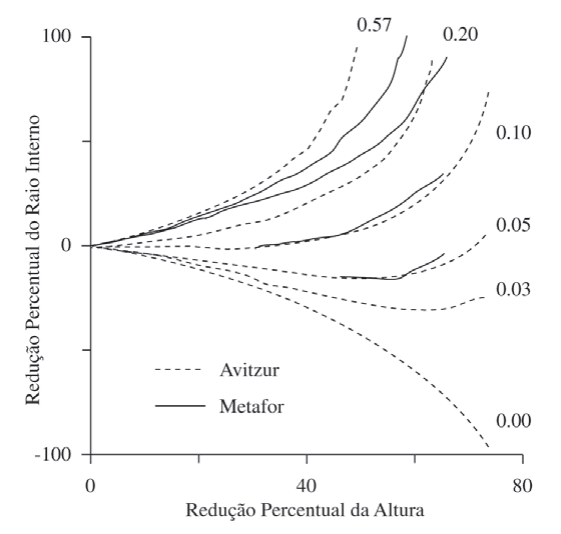
Figura 2. Comparação entre a solução numérica e a analítica 5 .